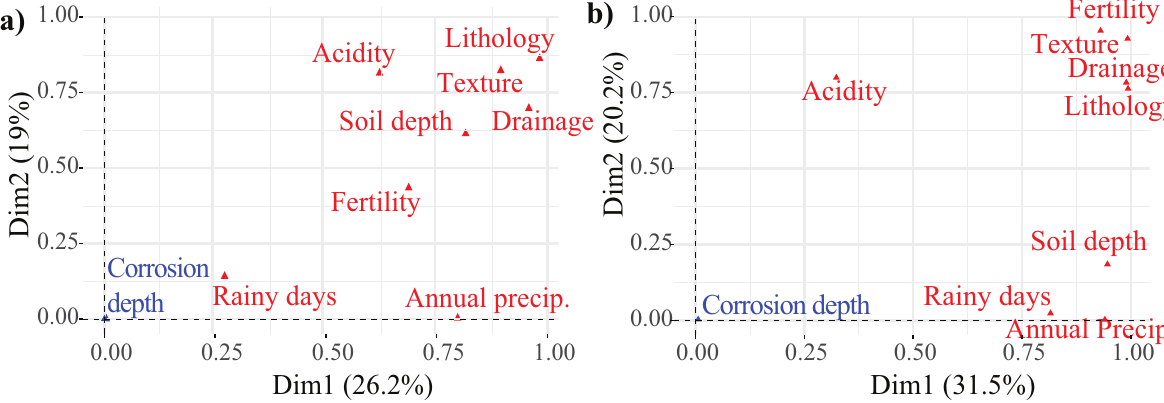
Figure 7. Variable correlation with the two principal MCA components ( η 2 ( v j , F 1 ) , η 2 ( v j , F 2 )) . ( a ) Inner and ( b ) Outer